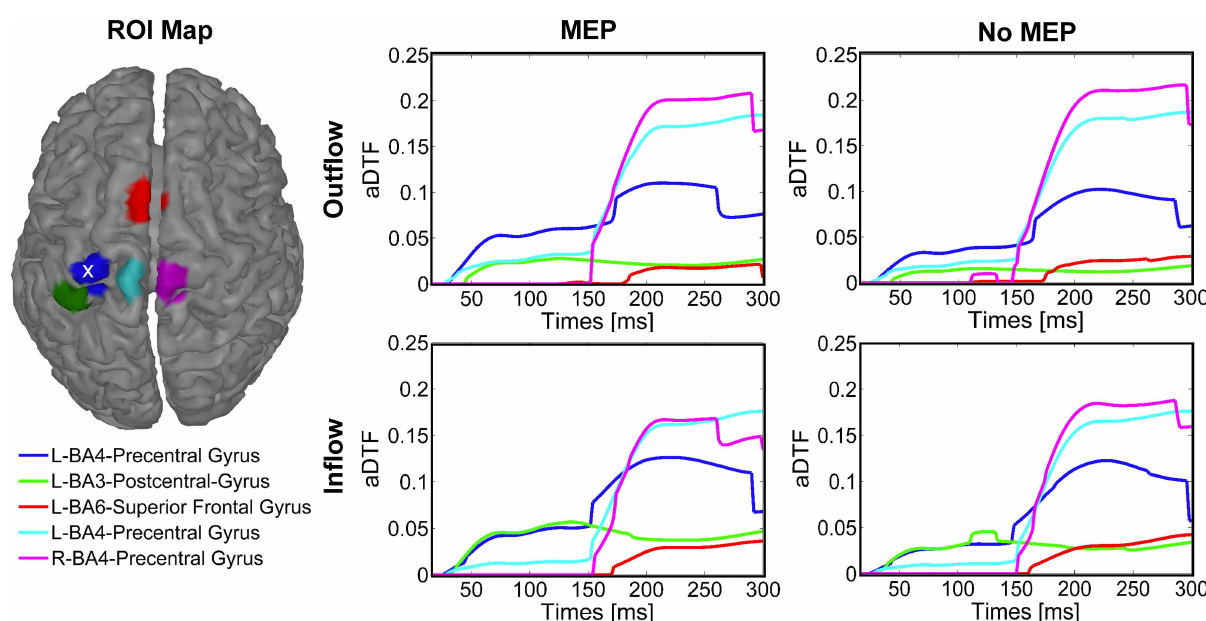
Fig 5. Inflow and outflow amongst ROIs for left M1 stimulation. Five ROIs were selected(left) using the cortical current density estimates for each latency (averageof 11 participants with simultaneous EMG recording). The ROI corresponding to the stimulationtarget is indicatedwith a white x. Time-varying connectivity, as measured by the aDTF, was calculatedfor each of the five ROIs for trials containing MEPs (middlecolumn) and trials without MEPs (right column), includingboth outflow (top row) and inflow (bottom row) patterns.